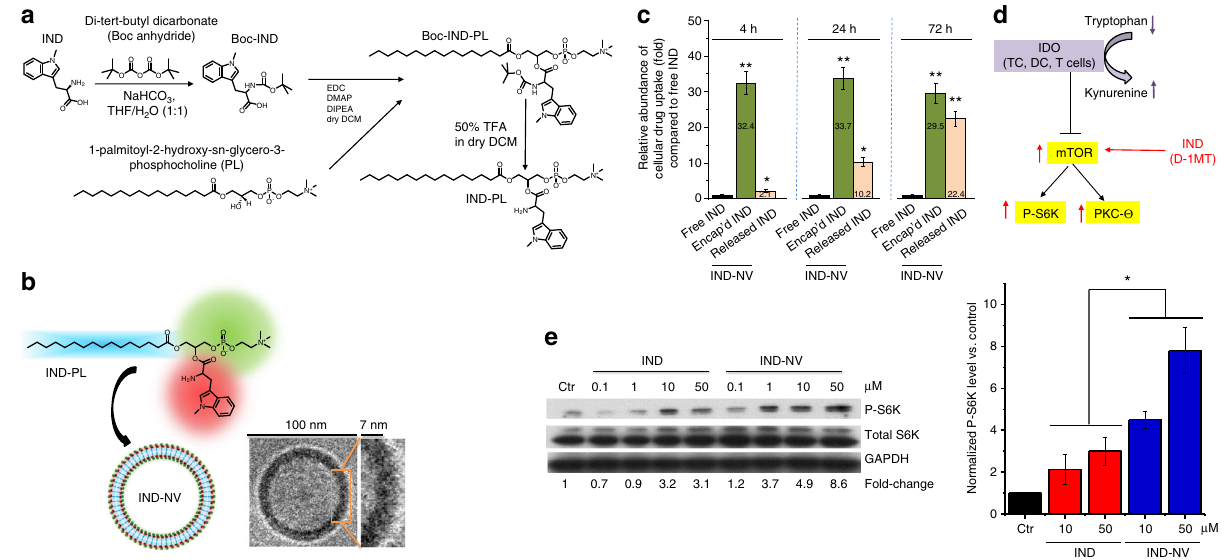
Fig. 3 Synthesis of a self-assembling indoximod (IND) prodrug for immune modulatory activity. a Detailed synthesis and characterization for generating the phospholipid-conjugated IND prodrug (IND-PL) appears in Supplementary Fig. 4. Successful synthesis of IND-PL was con fi rmed by a calculated m/z of 696.4353 during ESI-MS (Supplementary Fig. 4f, g). b Illustration depicting self-assembly of IND-PL nanovesicles (IND-NV), with IND securely anchored in the lipid bilayer. A representative cryoEM image of the spherical IND-NV, with diameter ~80 nm and lipid bilayer thickness of ~7 nm is shown as well. A lower magni fi cation cryoEM picture is shown in Supplementary Fig. 4h. c UPLC-MS/MS to determine the cellular uptake and release of IND-PL. KPC cells were treated with 100 µ g/mL free IND or IND-NV for the indicated incubation period, followed by collection of cells (via trypsinization) and drug extraction. The data show the fold-increase of the intracellular drug concentration as compared to free IND. A typical UPLC-MS/MS readout is shown in Supplementary Fig. 5. Details about the sample preparation and analysis are described in Supplementary Fig. 5. Three independent experiments were performed. d Role of IDO in providing immune suppression in the TME by inhibiting the mTOR pathway through Trp depletion. IND rescues this interference, acting as a highly potent Trp mimetic. This rescue leads to the phosphorylation and activation of P-S6K, as well as activation of PKC- ϴ that is involved in signal transduction by the T-cell antigen receptor; e KPC cells were treated with free IND or IND-NV at the indicated concentrations for 3 h in tryptophan-de fi cient DMEM. Western blot assays showing the enhanced effect of IND-PL on mTOR signaling, which can be conveniently studied by assessing the phosphorylation of P-S6K (upper panel). The graphic in the right panel shows the pooled data for 3 experiments to assess P-S6K activation at 10 μ M and 50 μ M IND. The results are expressed as mean ± SEM. * p < 0.05; ** p < 0.01,